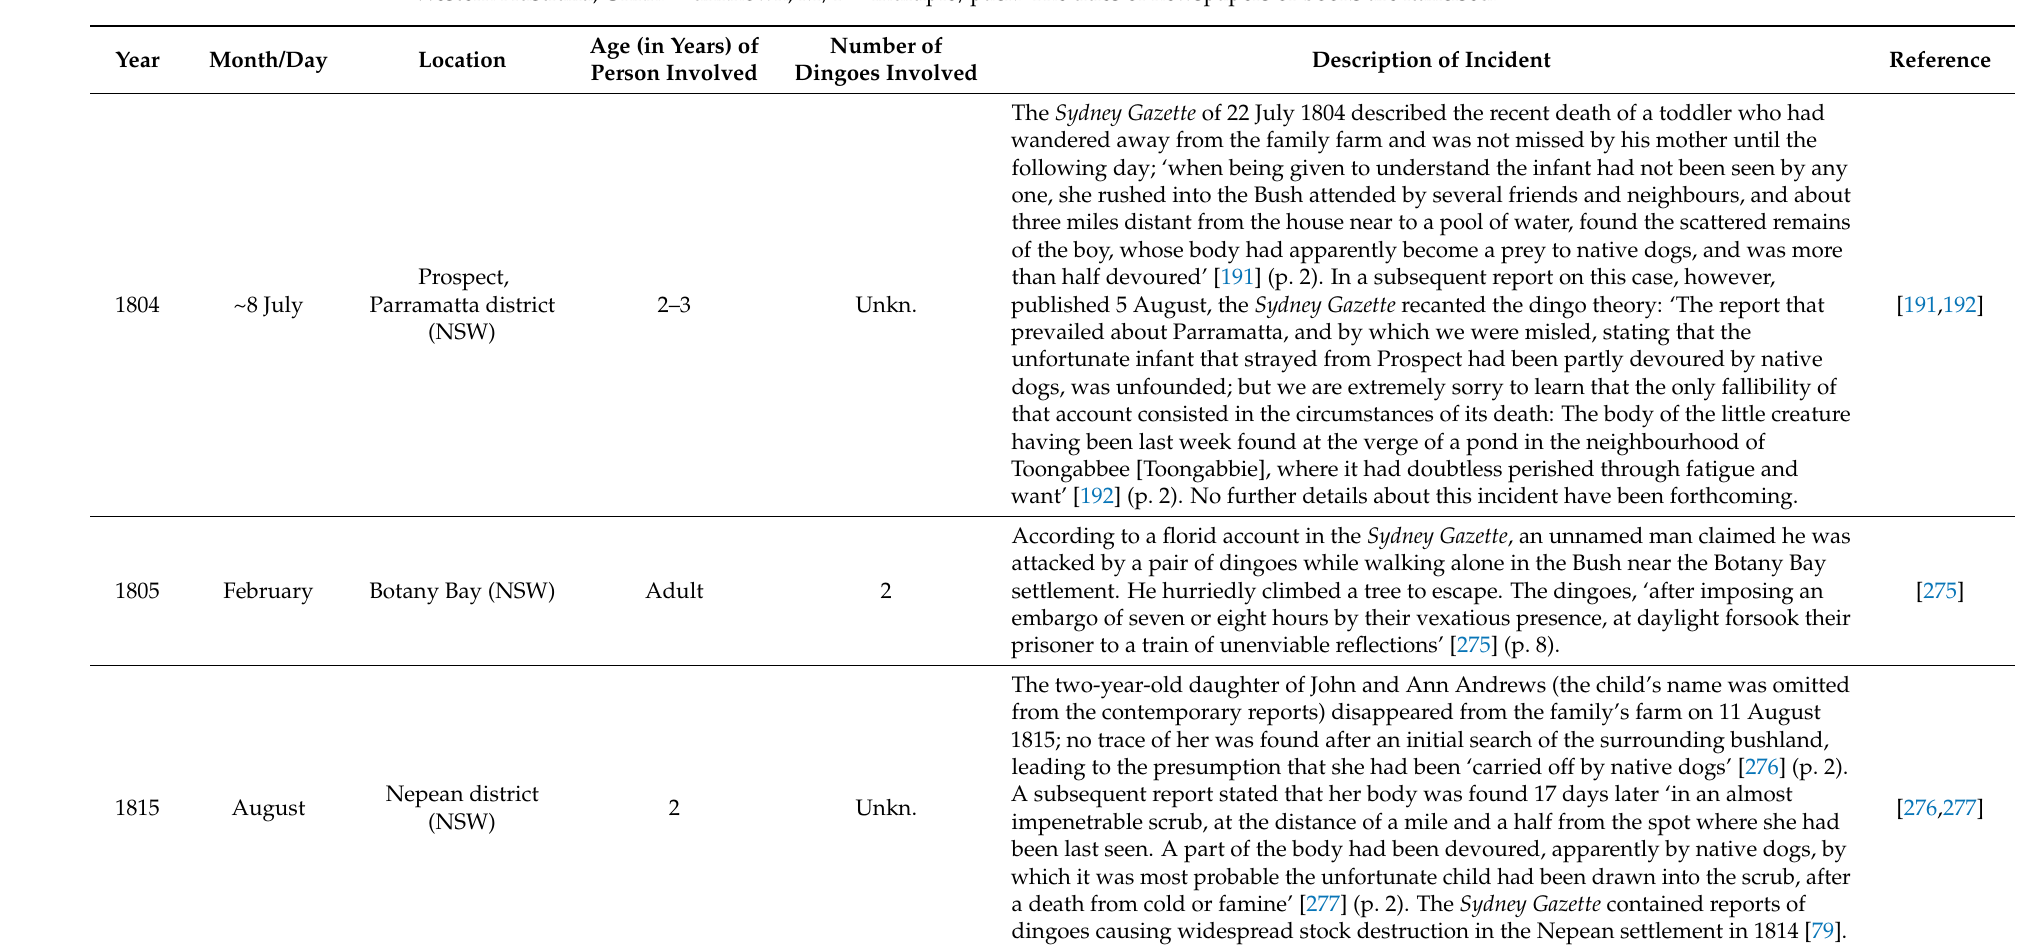
Table A1. Historical accounts of dingo attacks against non-Indigenous people in Australia. The table includes missing person cases involving children in which dingoes were alleged at the time to have been involved or were suspected of having been involved in the child’s disappearance (though in some cases alternative theories were entertained at the time). NSW = New South Wales; Qld = Queensland; Vic = Victoria; ACT = Australian Capital Territory; SA = South Australia; WA = Western Australia; Unkn. = unknown; M/P = multiple/pack. The titles of newspapers or books are